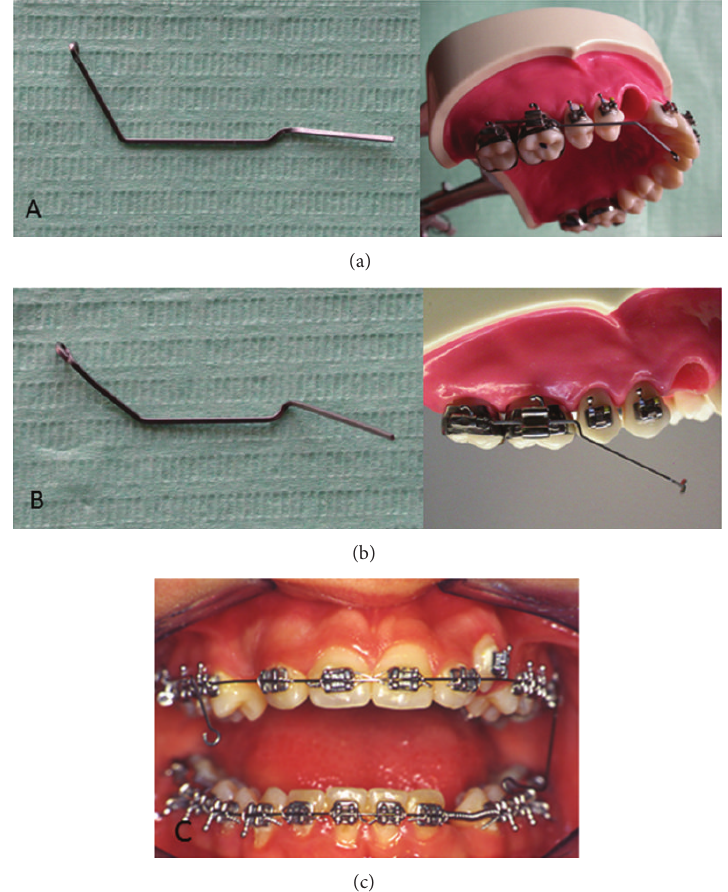
Figure 5: Cantilever activated for obtaining extrusion by a third order bend (a) and a second order bend (b). Cantilevers in position (c).